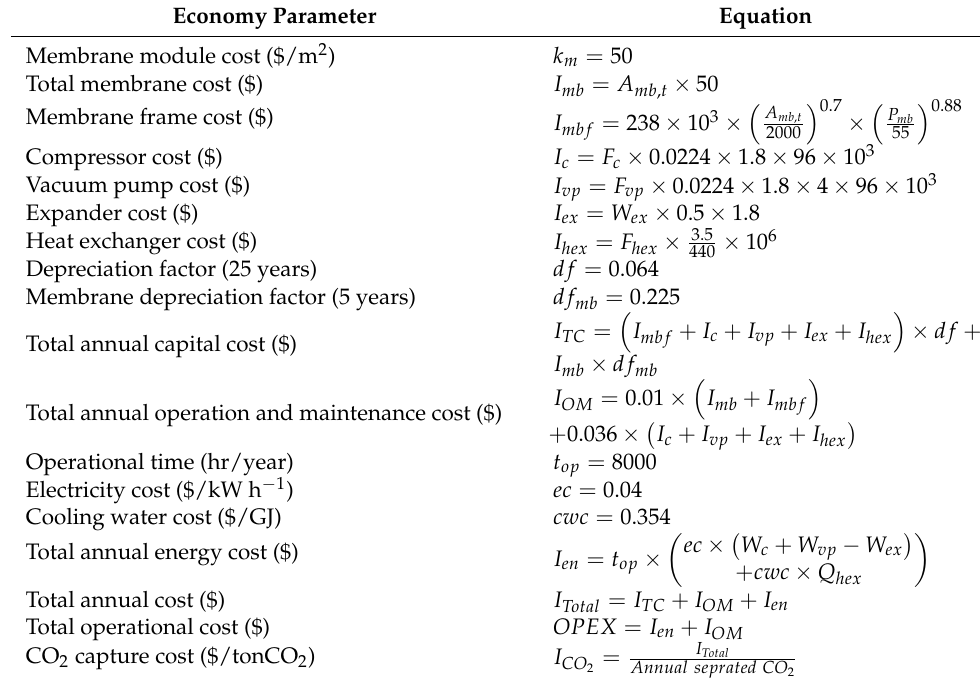
Table 3. Equations used for economic analysis of membrane-based CCS